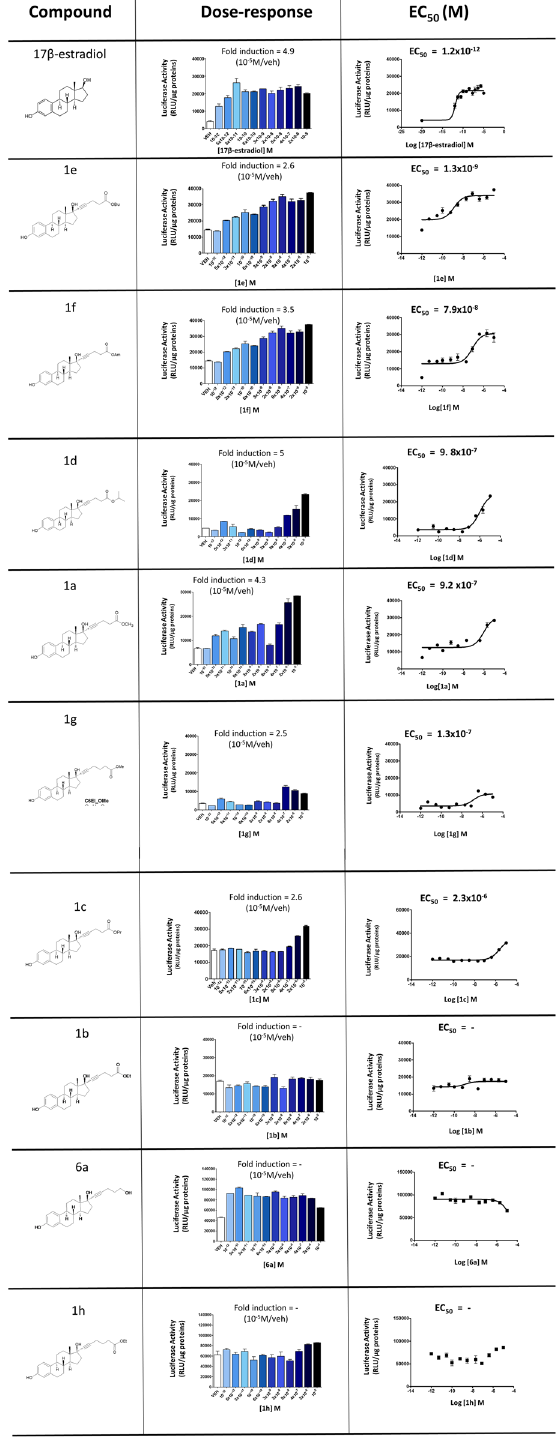
Figure 3. Compounds: chemical structure of tested compounds. Dose-response: ER transcriptional activity measured as luciferase activity in the presence of increasing concentrations of indicated compounds in the ERE- Luc B17 cells, fold induction of luciferase activity measured at 10-5 M of indicated compound respect to vehicle. EC50: plotting of the transactivation data for EC50 calculation by means of sigmoidal dose-response (variable slope) using PRISM5